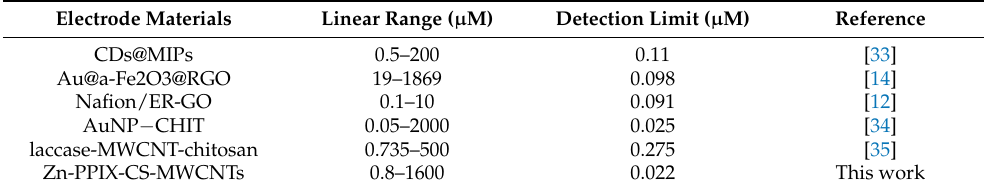
Table 1. Comparison of electrochemistry biosensors modified by different nanomaterials for the detection of caffeic acid.